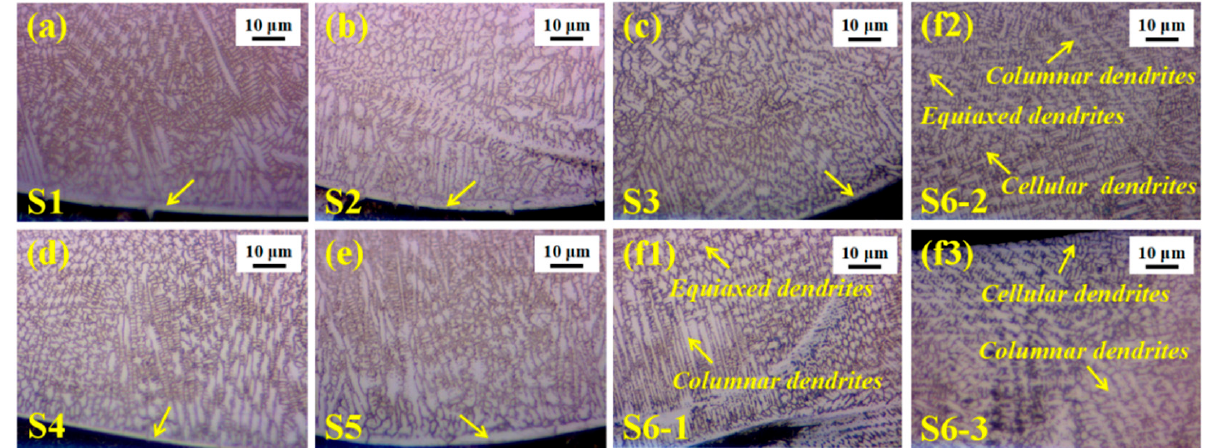
Figure 3. The high-magnification OM diagrams of the bonding interface and the different areas of S6. ( a ) S1; ( b ) S2; ( c ) S3; ( d ) S4; ( e ) S5; ( f1 ) S6 (the bottom); ( f2 ) the middle; ( f3 ) the